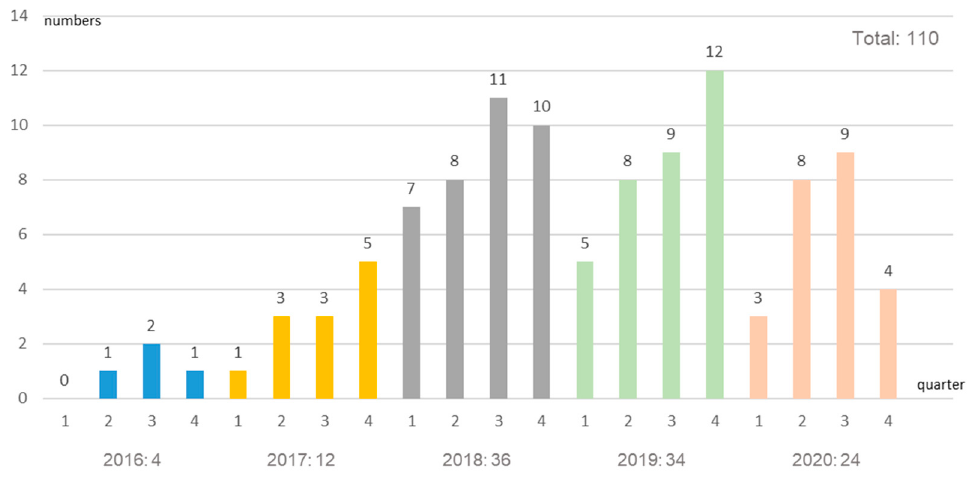
Figure 2. Number of MSI Images acquired over Chaohu Lake between 2016 and 2020.